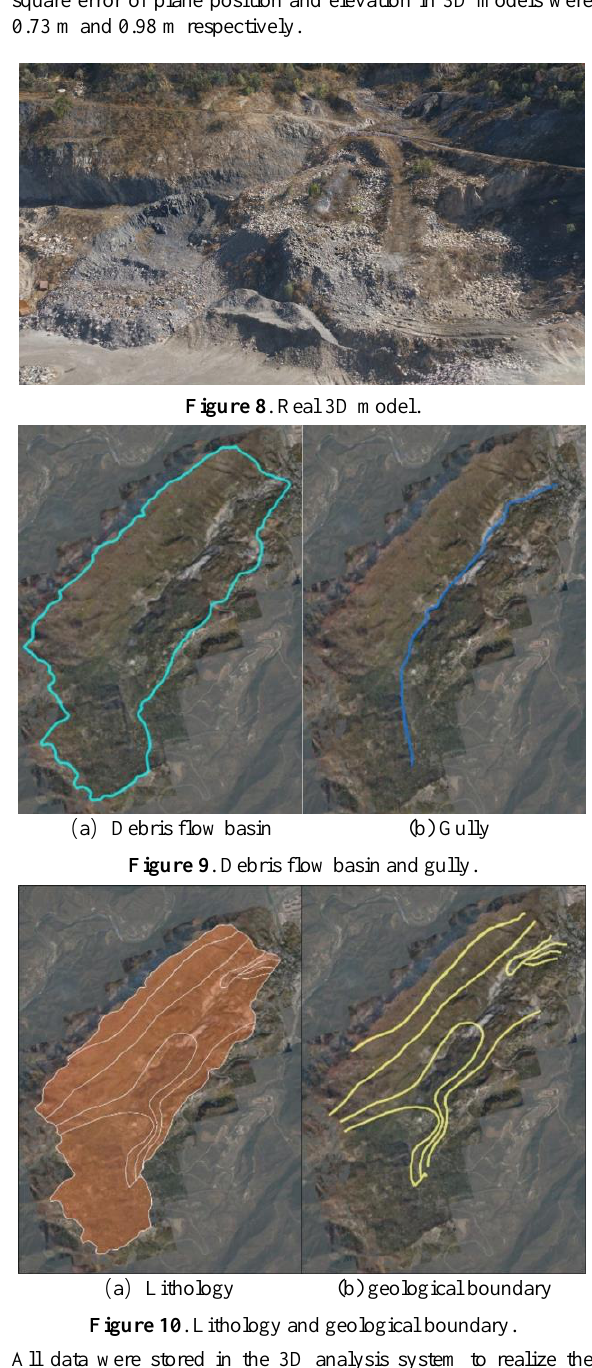
Figure 10 . Lithology and geological